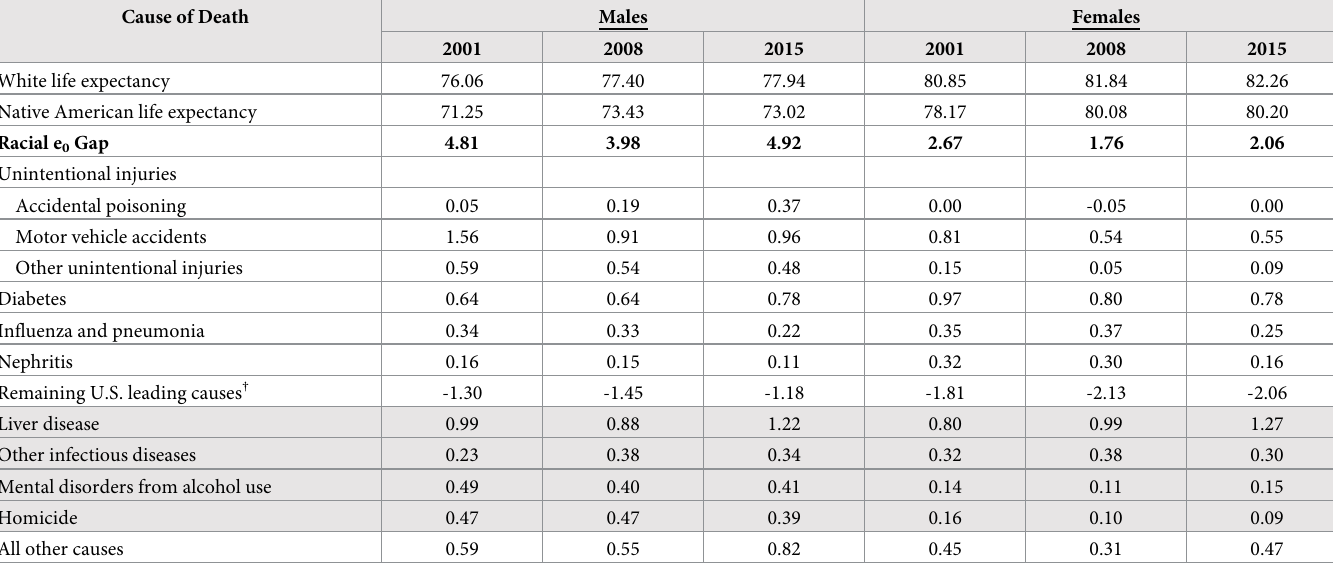
Table 2. Contribution of eleven selected causes of death to Native American-White life expectancy gaps in the Four Corners States. Cause of